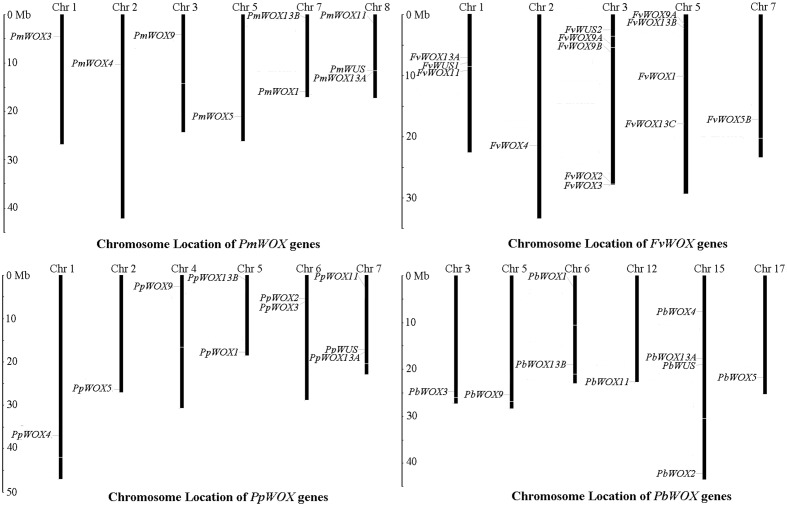
Chromosomal location of WOX genes from Pyrus bretschneideri, Prunus persica, Fragaria vesca and Prunus mume. The chromosome number was represented by the top of each chromosome.